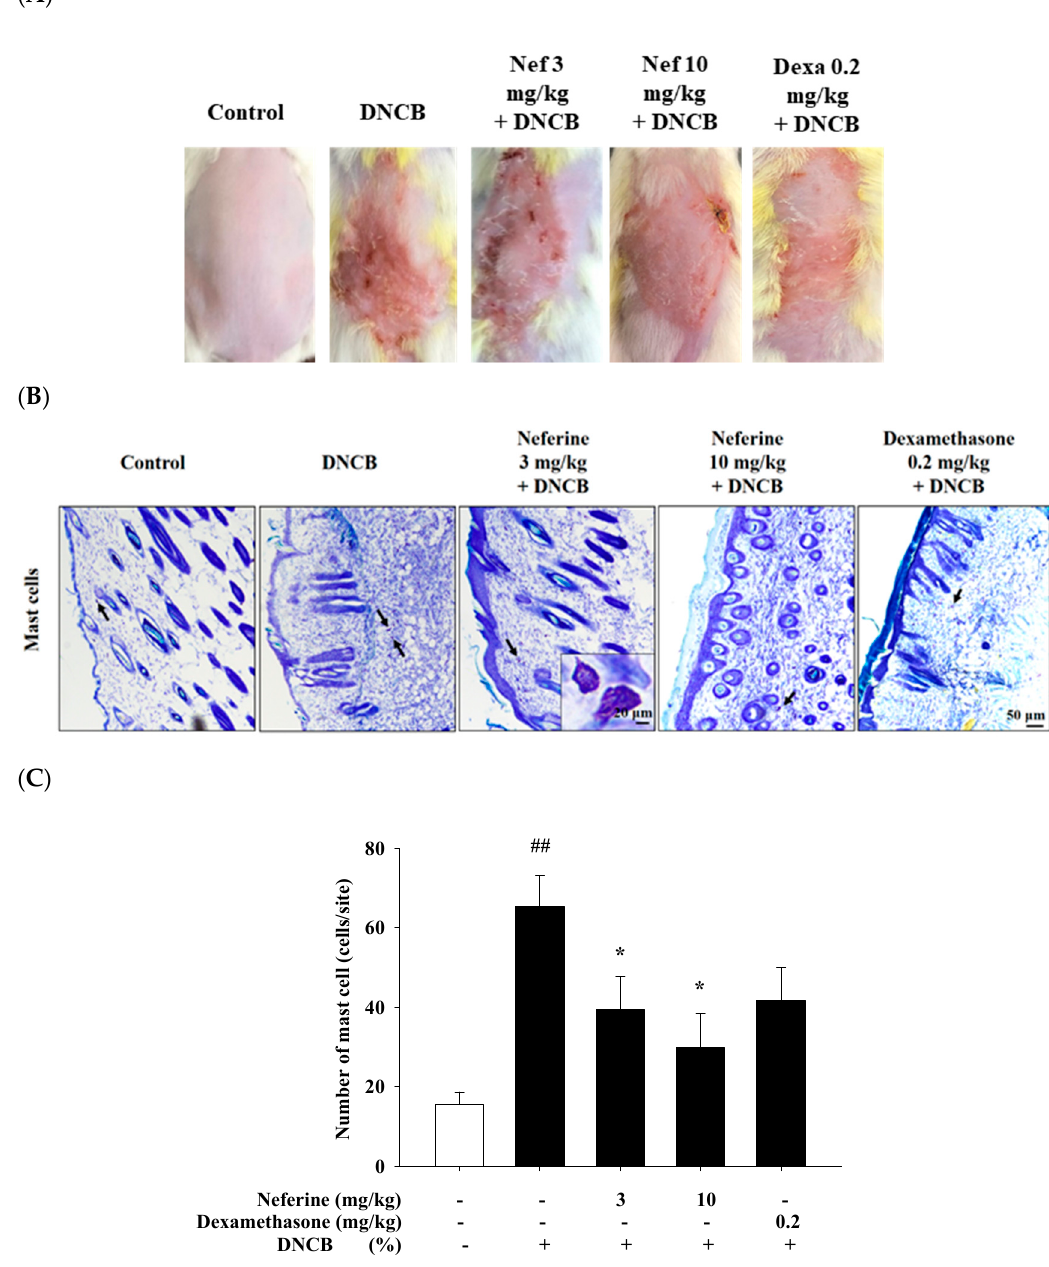
Figure 7. Histological analysis to assess the effect of neferine on atopic dermatitis (AD)-like skin lesions and mast cell infiltration after the 15th DNCB challenge. ( A ) Phenotypic presentation of mouse skin after 15 days treatment. ( B ) Toluidine blue staining; scale bar: 50 μ m. ( C ) Number of mast cells. ## p < 0.01 compared with the no-treatment condition, * p < 0.05 compared with the only DNCB treatment condition.